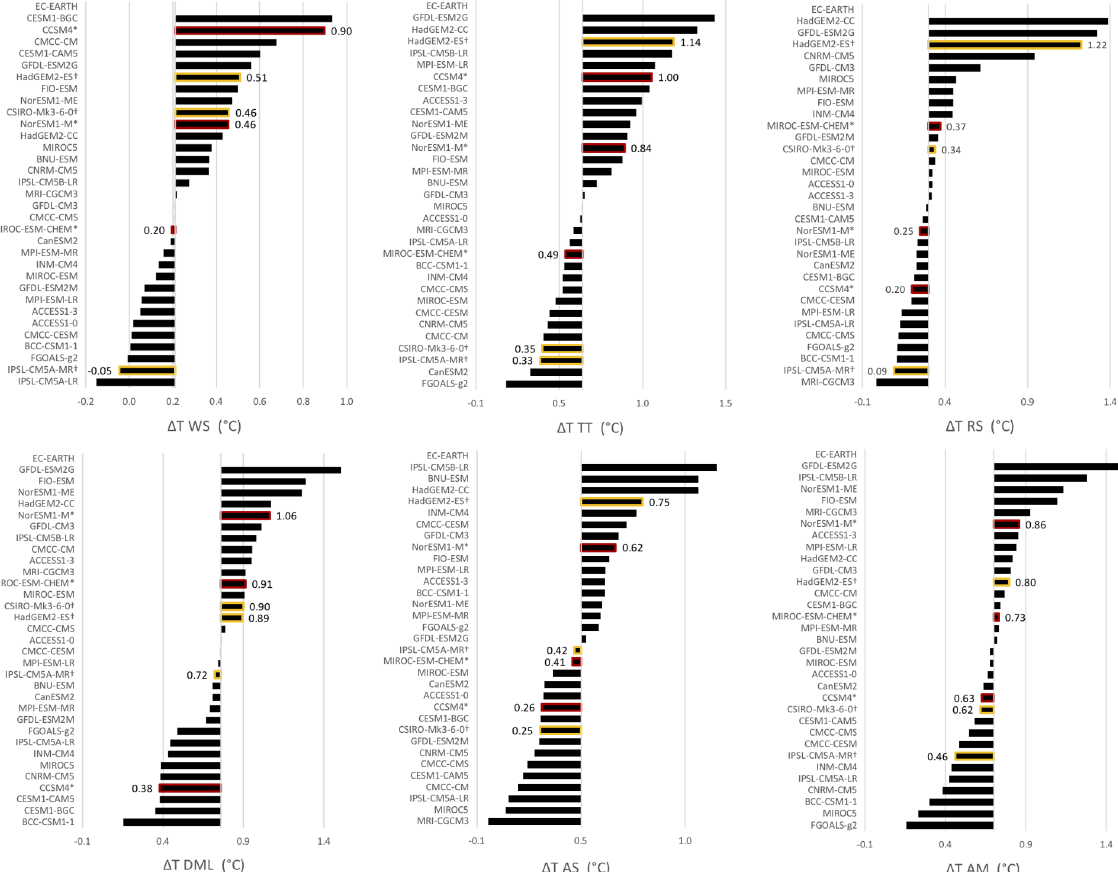
Figure B1. Projected RCP8.5 warming for each CMIP5 model between 1980–2000 and 2080–2100 in the six Antarctic shelf regions (WS: Weddell Sea; TT: Totten; RS: Ross; DML: Dronning Maud Land; AS: Amundsen; AM: Amery). The symbols * and † identify models selected in the top three and top six ensembles,